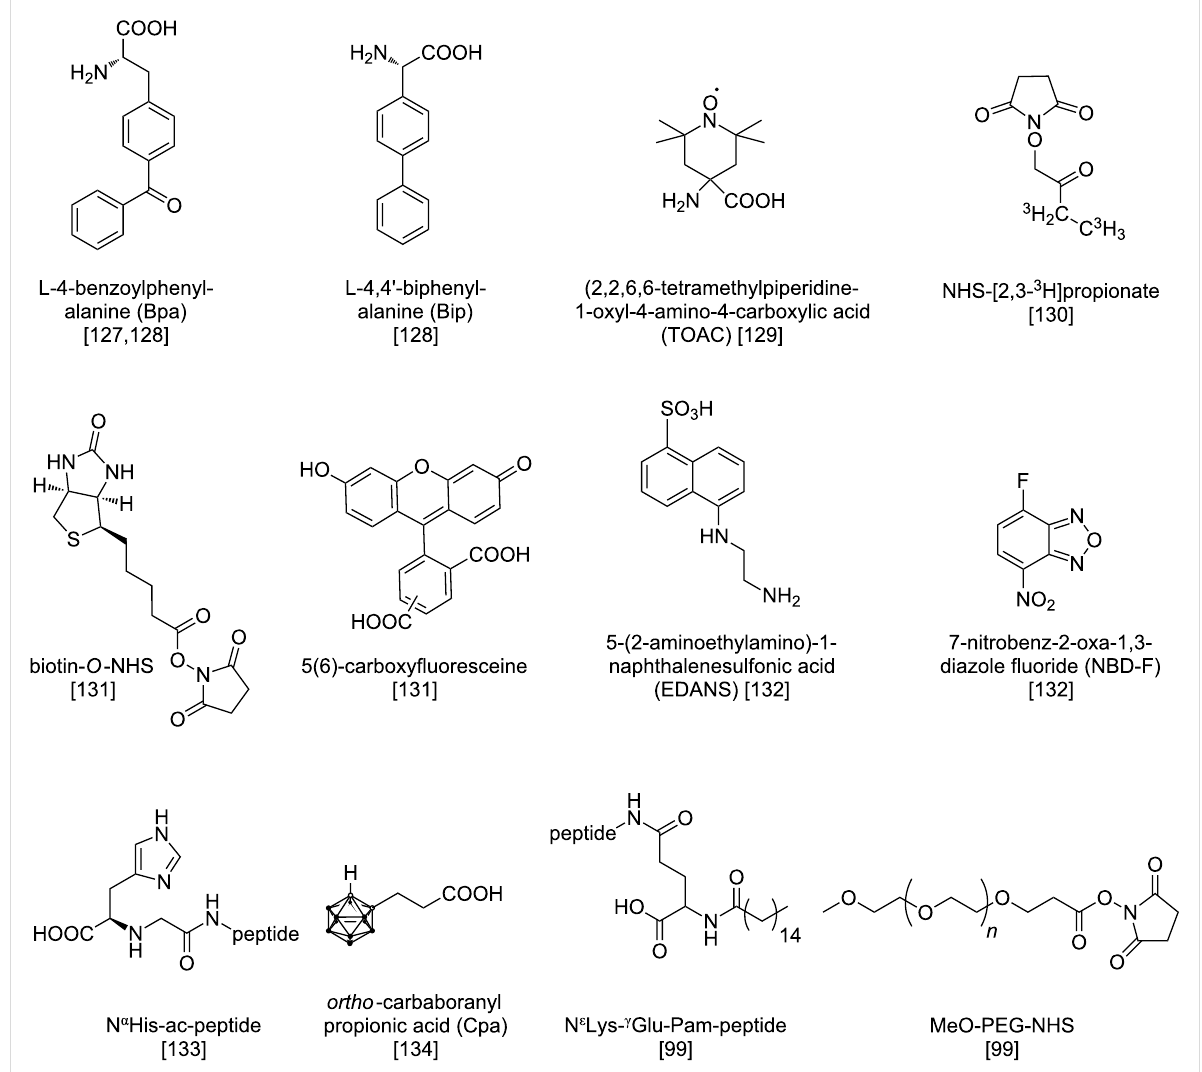
Figure 5: Compounds that can be introduced into pNPY (porcine neuropeptide Y) or hPP (human pancreatic polypeptide). NHS: N -hydroxysuccin- imidyl, Pam: palmitoyl residue.